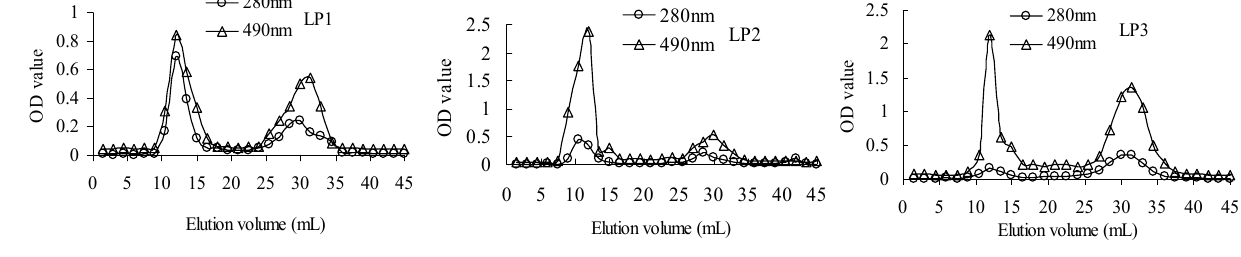
Figure 1. Gel column chromatograms of LP1-3.Polysaccharides and proteins were detected by phenol-sulfuric acid method at 490 nm and UV measurement at 280 nm, respectively.